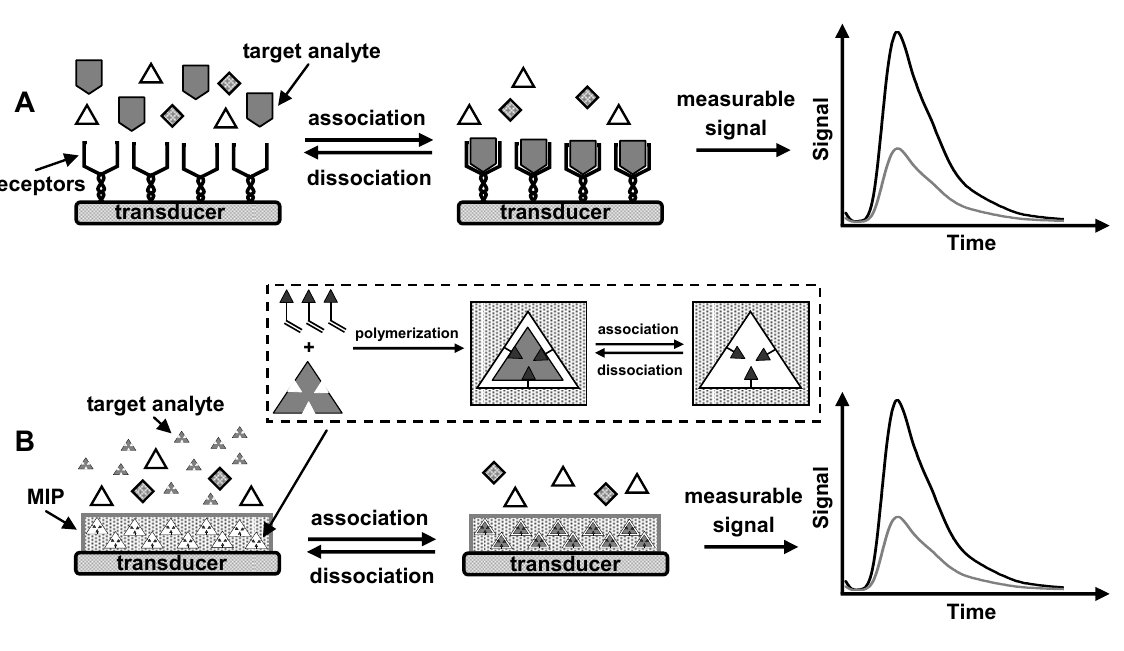
Figure 1. Schematic representations of (A) antibody-based chemosensor and (B) MIP-based biomimetic sensor. Inset in (B) shows the concept of molecular